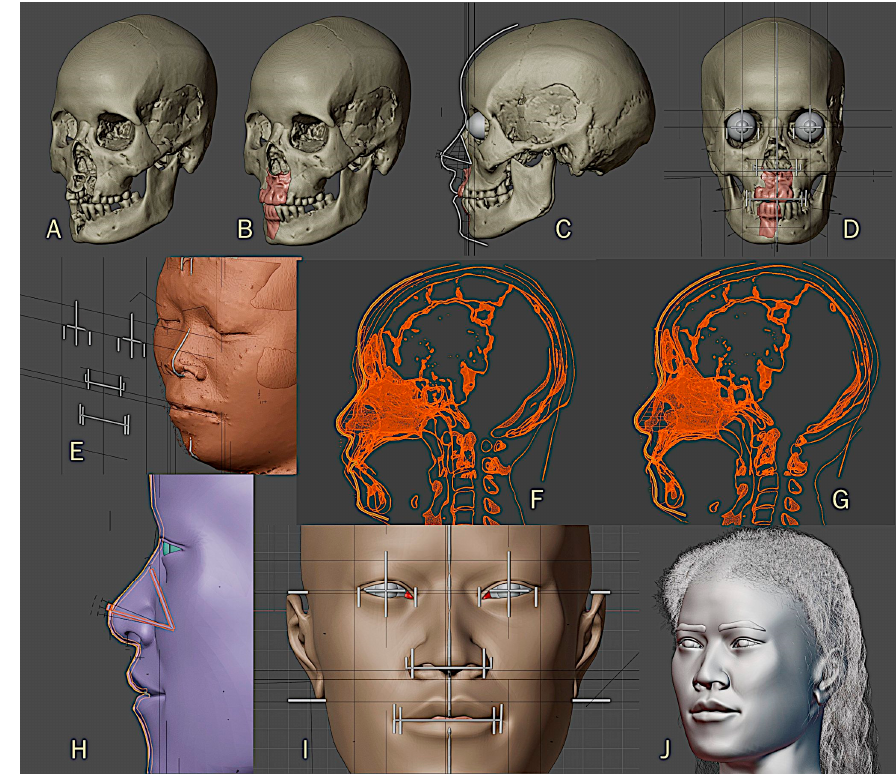
Figure 5. The steps of forensic facial approximation. ( A ) The reconstructed skull was incomplete; thus it was filled with a 3D mesh from a virtual donour ( B ). A profile line of the face was drawn ( C ) and the frontal projections was generated ( D ). Anatomical deformation technique was performed to approximate the face ( E ). Comparable nasal deformity was observed ( F , G ). A series of structural modifications was performed to adapt with the projections ( H , I ). The hairs were added to complete the facial approximation ( J ).